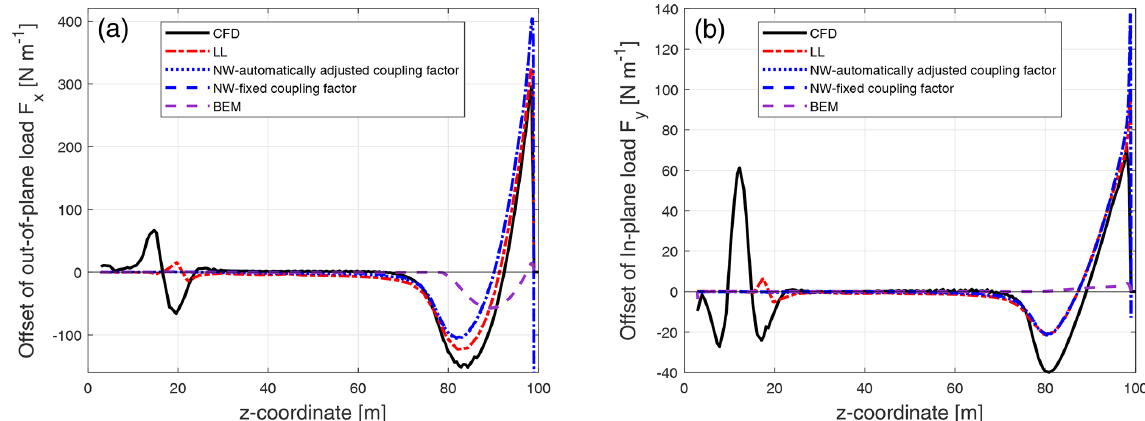
Figure C2. Comparison of the difference between the out-of-plane load (a) and the in-plane load (b) of the backward swept Blade-3 with respect to the baseline blade calculated from the Navier–Stokes solver (CFD), the lifting-line method (LL), the proposed coupled method (NW) and the blade element momentum method (BEM).